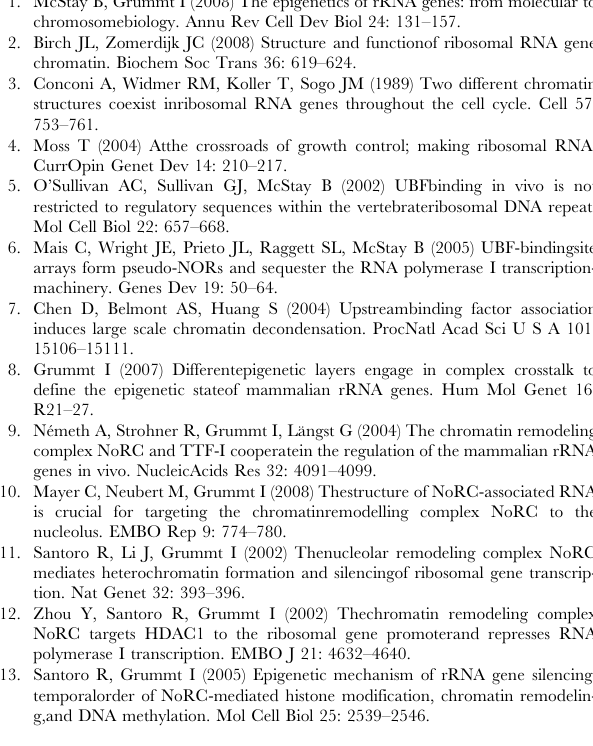
ChIP of serum-starved cells (lower panel) with antibodies indicated below, in which PCR primers at the positions along the rDNA repeat as indicated were used. One representative experiment out of six is presented with the values adjusted to the signal for the relevant histone for each primer. (TIF) Figure S5 GCN5 and p300 does not interact directly with WSTF. Immunoblot (10% SDS-PAGE) of immunoprecip- itations using antibodies against WSTF, GCN5 and p300, as indicated, of nuclear extracts prepared at 0.2 M KCl and 0.7 M KCl. Co-immunoprecipitated proteins were detected with the antibodies marked at the left. IgG was used as a control. (TIF) Table S1 Primers used in the study (based on the human rRNA gene repeat, U13369). (DOC) Table S2 Primers used in the high resolution MNase assay, investigating 1 kb upstream of the transcription start